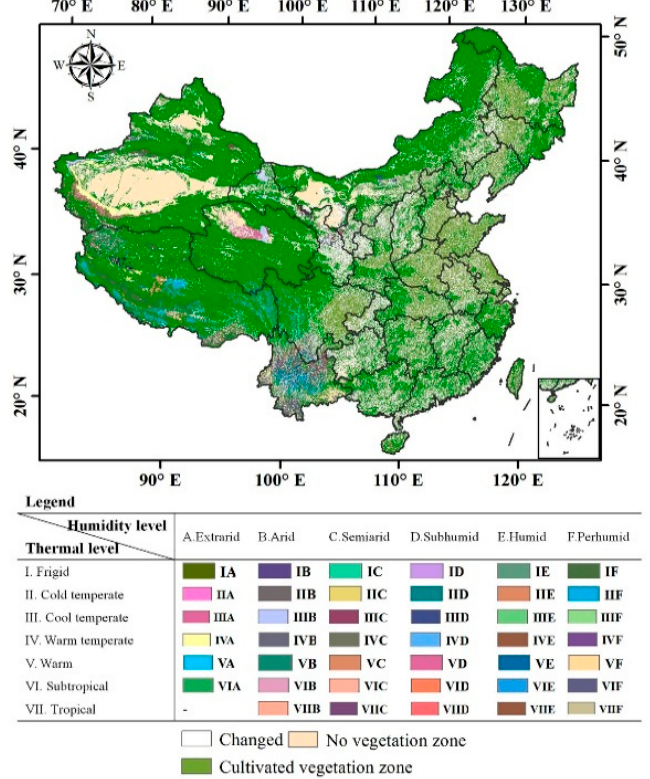
Figure 12. Spatial distribution of PNV in typical areas in the baseline scenario. Although the relationship between the DEMmean range of PNV in typical areas and their thermal level is observed to be overall similar to that of existing PNV, both the DEMrange and DEMstd of each PNV in typical areas decrease significantly rela- tive to existing PNV, especially for frigid–humid tundra and alpine meadow (Table A2 and Figure